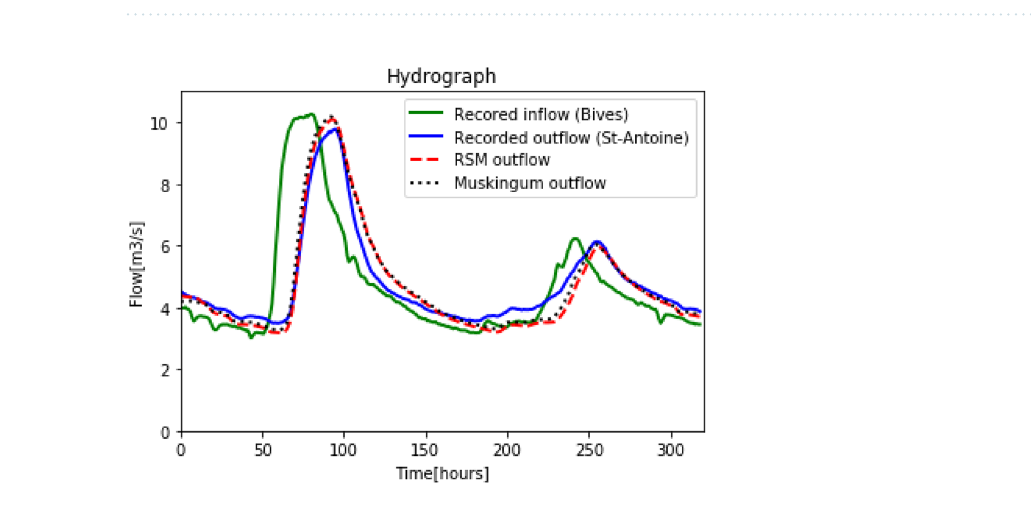
Figure 9. Calibration: Recorded inflow in Bives, recorded outflow in St-Antoine, reconstructed outflow for the RSM and the Muskingum models.